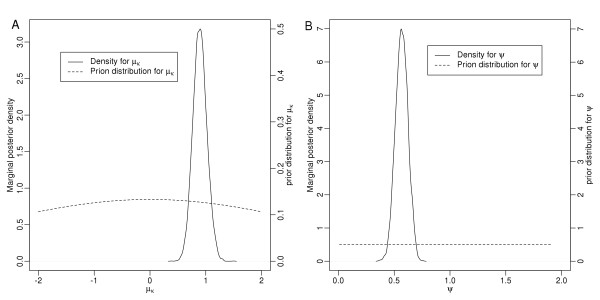
Marginal posterior density and prior distribution for the global parameter (A) μκand (B) ψ.